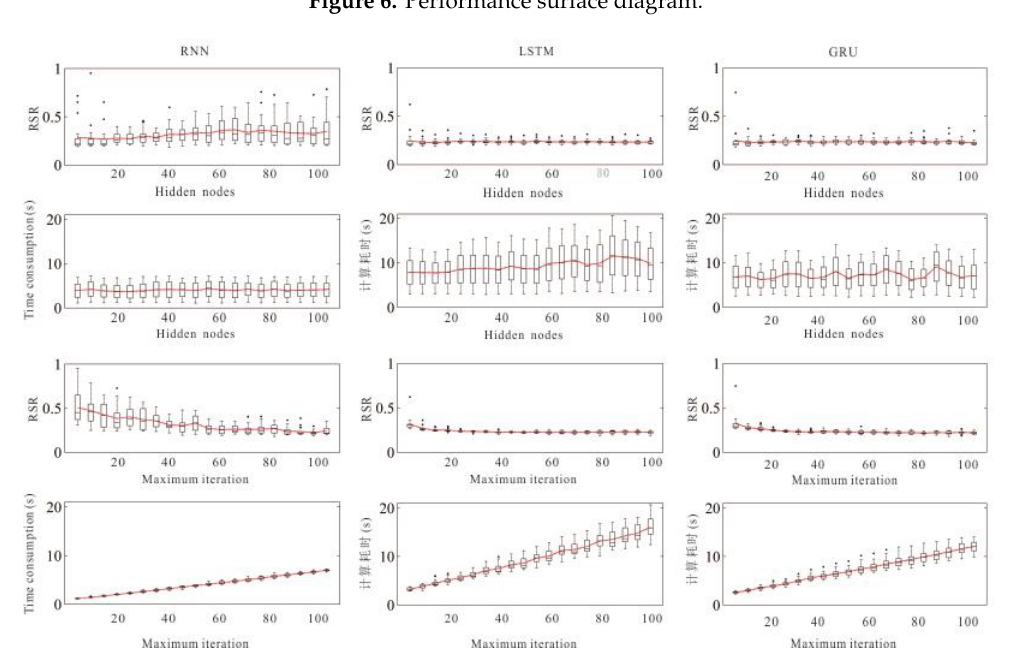
Figure 7. The influence of hidden nodes and iterations on model performance.